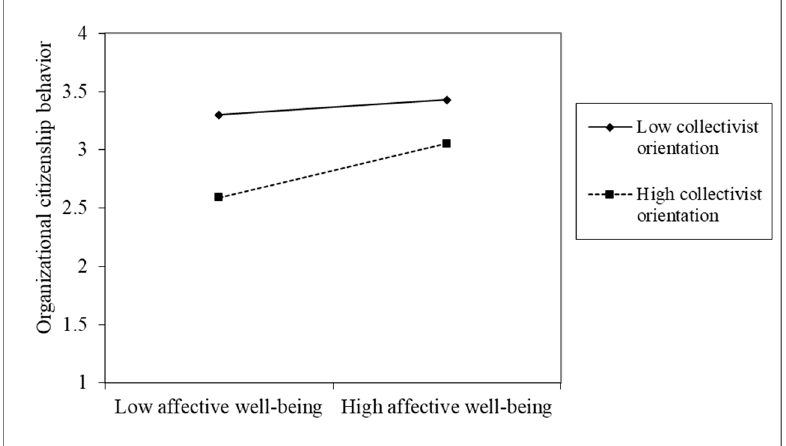
Figure 3. Effect of the interaction between affective well-being and collectivist orientation on organizational citizenship behavior.